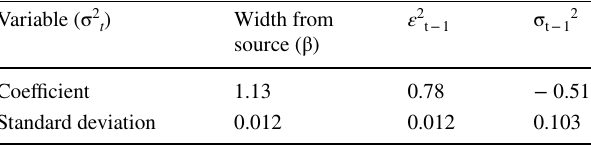
Table 2 Equation of conditional variance of evapotranspiration by the FAO Penman–Monteith method